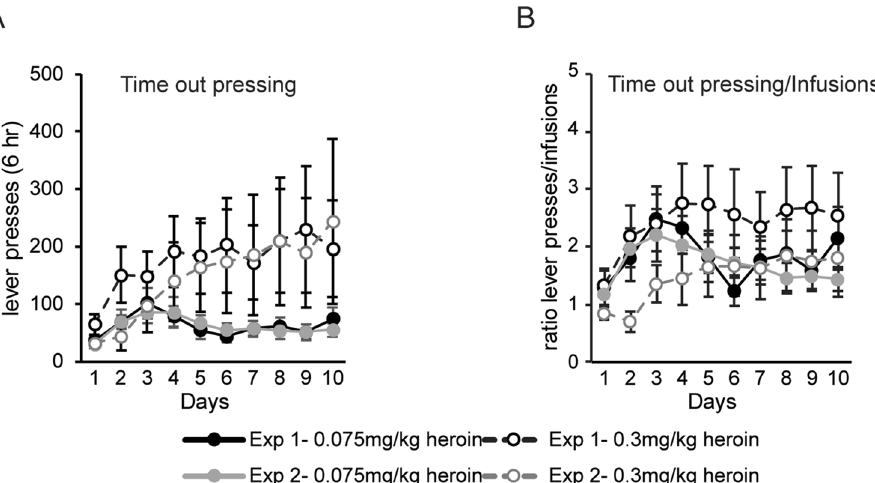
Figure 3. The amount of time-out pressing was not changed by drug dosage or drug-associated cues. ( A ) The number of lever presses on the active lever during the 20-s time-out period that followed each infusion was measured for each experimental protocol. ( B ) The amount of time-out pressing was calculated by adjusting for the total number of infusions made in each experimental protocol. Shown are active lever time-out presses divided by the number of infusions for experiments 1 and 2. Error ±